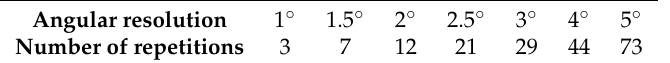
Table 2. Angular resolutions used for the 3D scan optimization and corresponding number of repetitions for each laser beam orientation. Note that the elevation and azimuthal angular resolutions are kept the